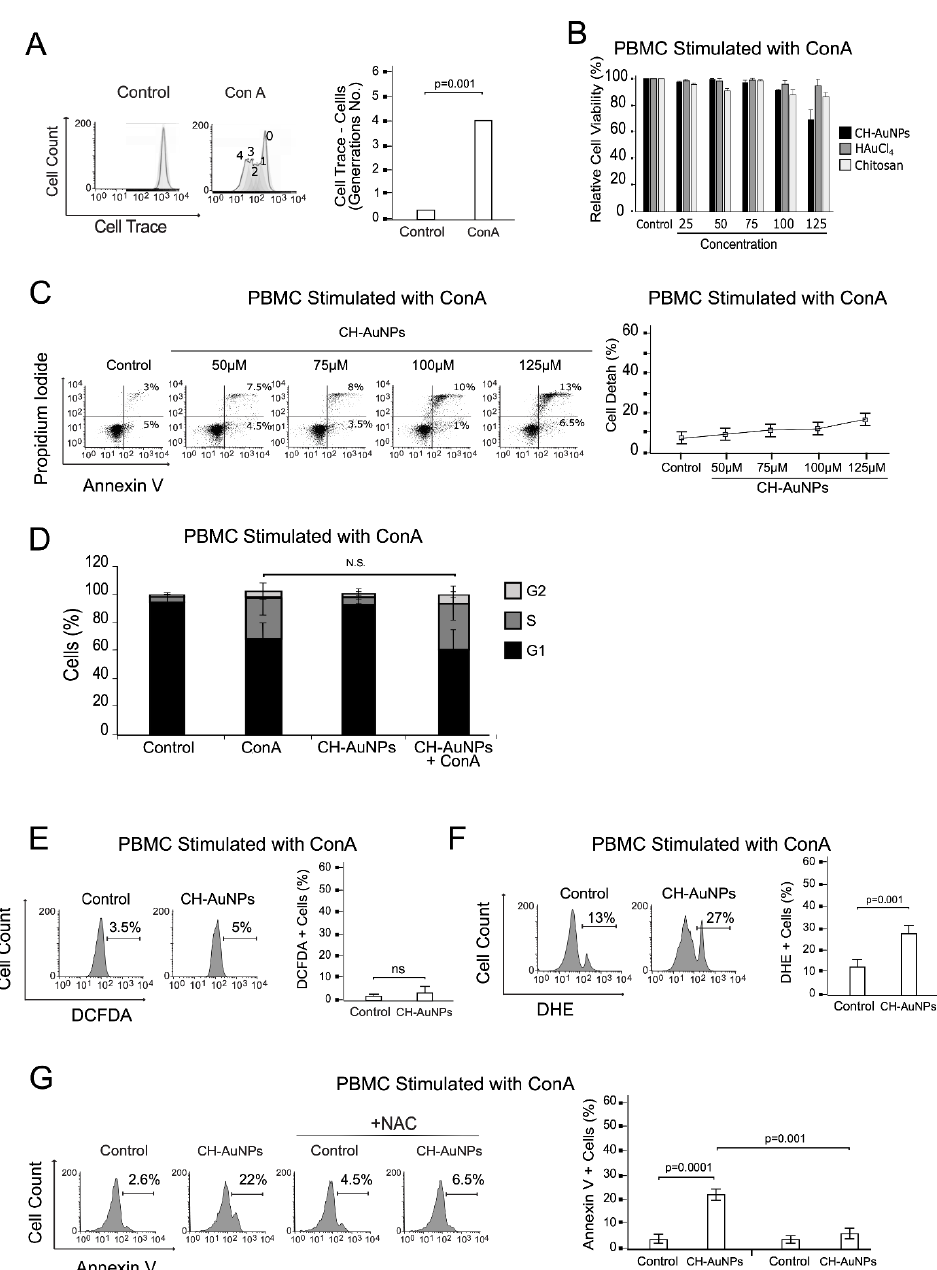
Figure 5. Effect of CH-AuNPs on primary PBMCs stimulated with the mitogen concanavalin A. ( A ) Representative histograms ( right ) and quantification ( left ) of cell proliferation by flow cytometry through CFSE staining in PBMCs left untreated or treated with the mitogen concanavalin A (ConA) for 96 h. ( B ) Cell-viability analysis of PBMCs with ConA treated with CH-AuNPs, HAuCl 4 , and chitosan (25, 50, 75, 100, and 125 µ M) for 24 h. ( C ) Cell-death analysis ( left ) and quantification ( right ) of PBMCs with ConA treated with CH-AuNPs (25, 50, 75, 100, and 125 µ M) for 24 h. ( D ) Quantification of cycle distribution of PBMCs with or without ConA and treated with 125 µ M of CH-AuNPs for 24 h. ( E ) ROS (H 2 O 2 ) analysis ( left ) and quantification ( right ) by flow cytometry through DCFDA staining of PBMCs with ConA treated with CH-AuNPs for 24 h. ( F ) ROS (O 2 − ) analysis ( left ) and quantification ( right ) by flow cytometry through DHE staining of PBMCs with ConA treated with CH-AuNPs for 24 h. ( G ) Representative dot plots of cell-death analysis ( left ) and quantification ( right ) of PBMCs with ConA treated with CH-AuNPs for 24 h, using NAC as a ROS inhibitor for 24 h. The results are presented as mean standard deviation of three different experiments. N.S. = not ±